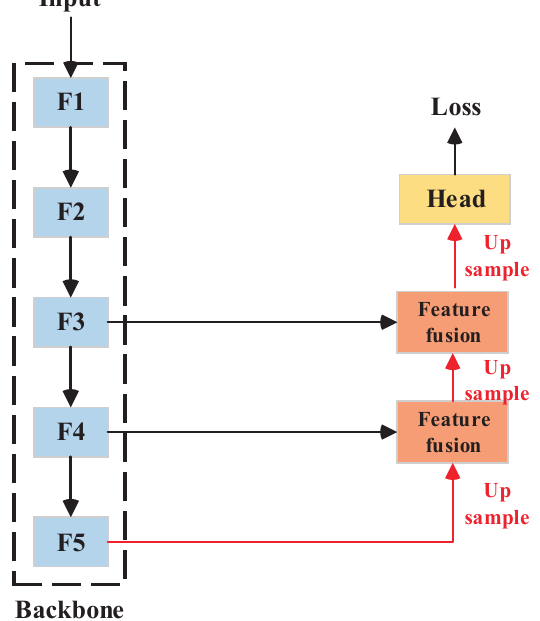
Figure 4. Thg general semantic segmentation